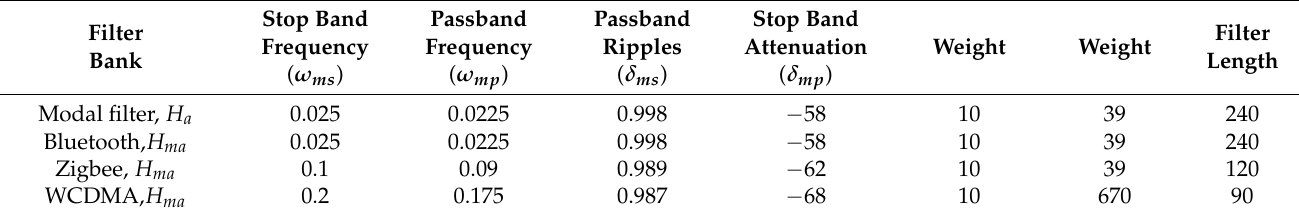
Table 3. The frequency characteristics of the modulated filter when m =